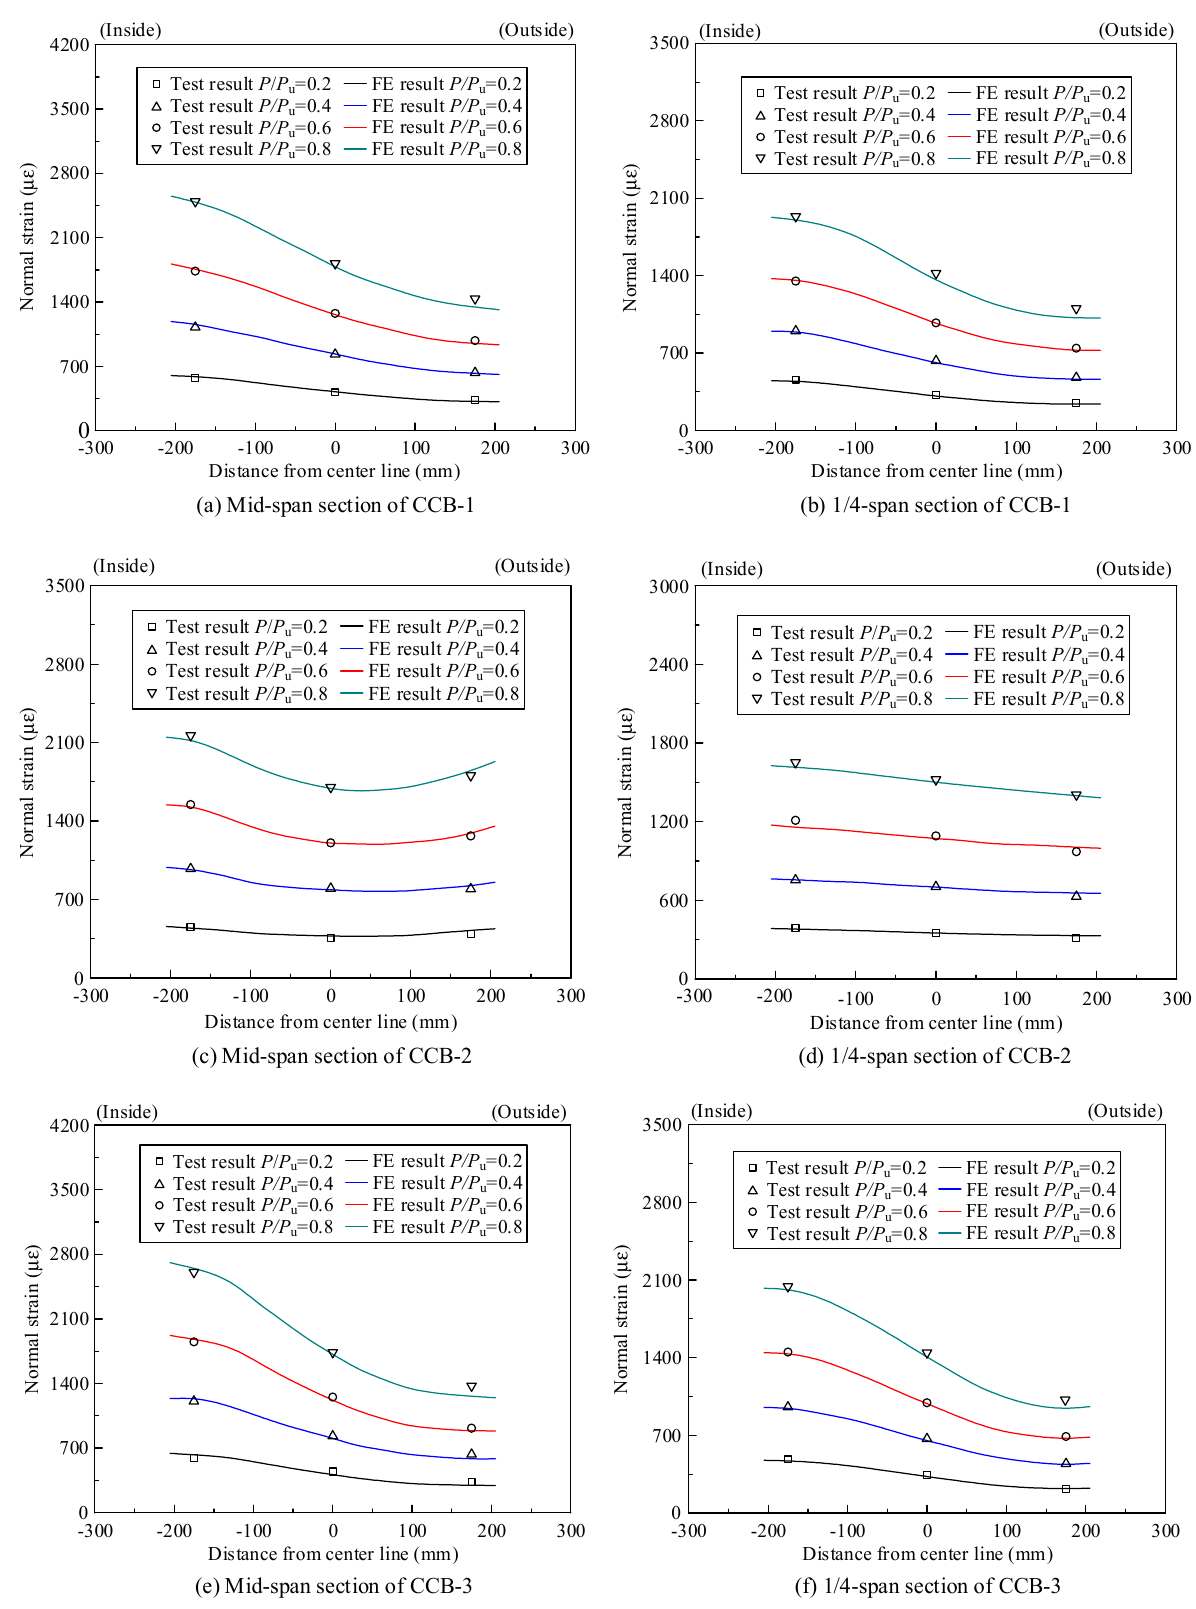
Figure 21. Comparison of the normal strains of the steel bottom flanges from the test and numerical analyses.